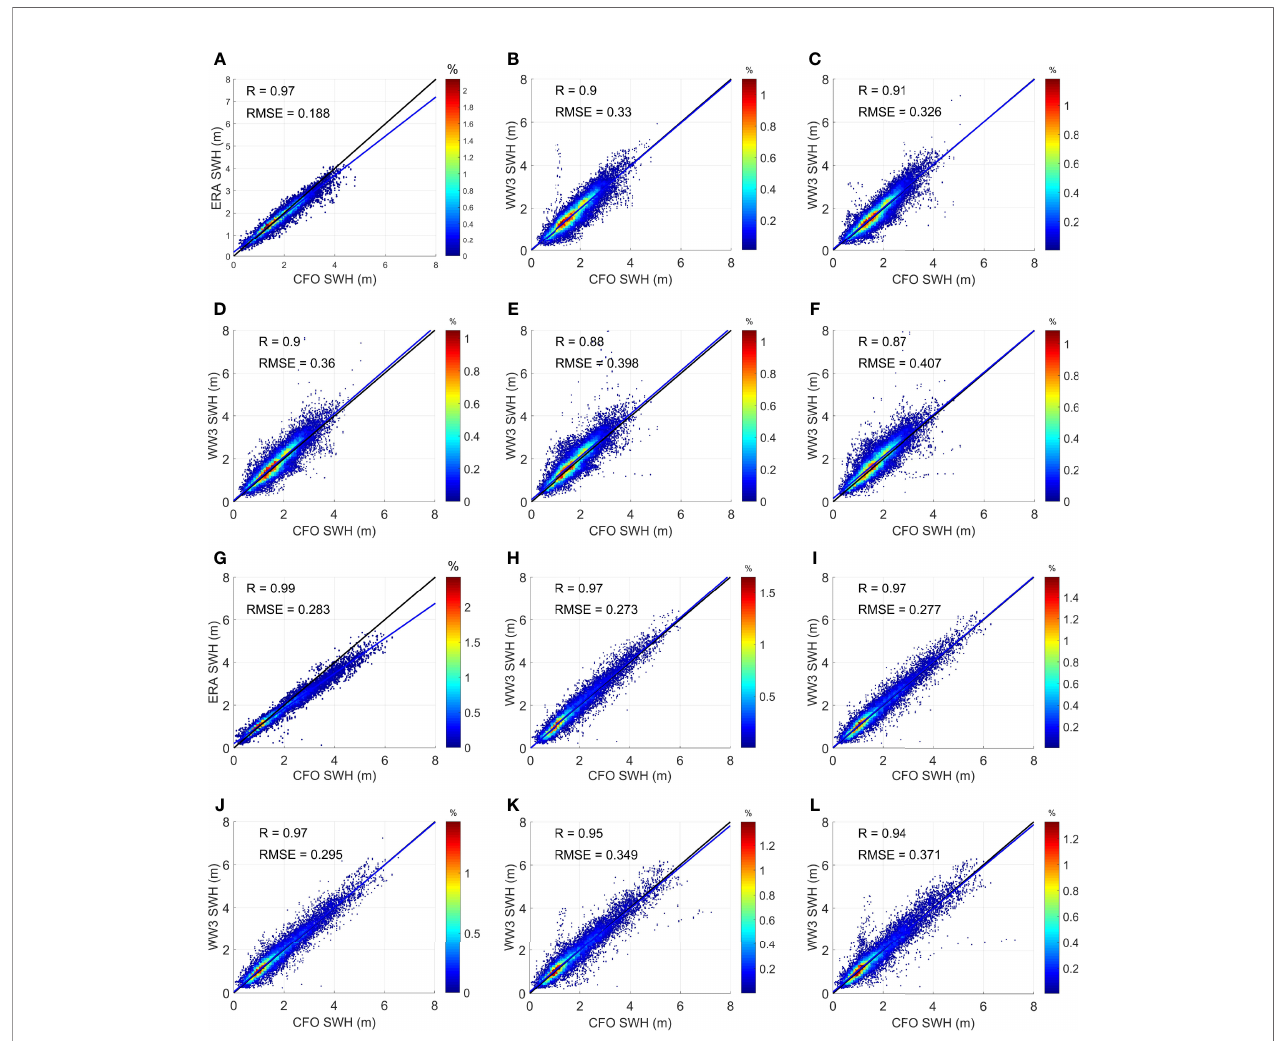
FIGURE 7 | Scatter plot of signi fi cant wave height (SWH) from observations of CFOSAT (unit: m) and (A, G) reanalysis of ERA5, (B, H) 0 – 24 h, (C, I) 25 – 48 h, (D, J) 49 – 72 h, (E, K) 73 – 96 h, and (F, L) 97 – 120 h forecasts of (A – F) WW3-D02_2 in the EIO and (G – L) WW3-D02_1 in the WIO (see Figure 2 ). R is the correlation coef fi cient, and RMSE is the root mean square